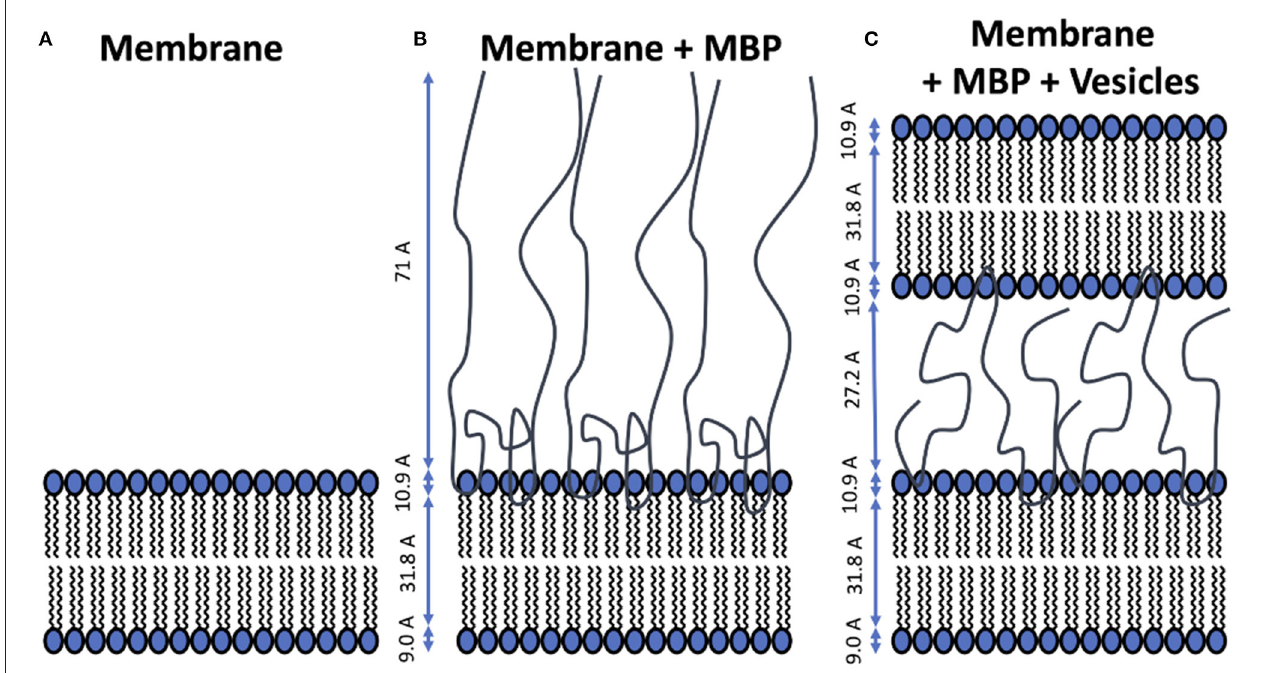
FIGURE 2 | Schematic representation of structural models for the different stages of the experiment. The averaged thickness values of the membrane components are indicated in the figure panels. (A) Supported membrane bilayer formed by vesicle fusion on silicon wafer. (B) MBP-coated membrane formed after injection of protein solution and incubation. (C) Double-layer membrane structure connected by a dense MBP phase in between that is formed upon adhesion of the LUVs.